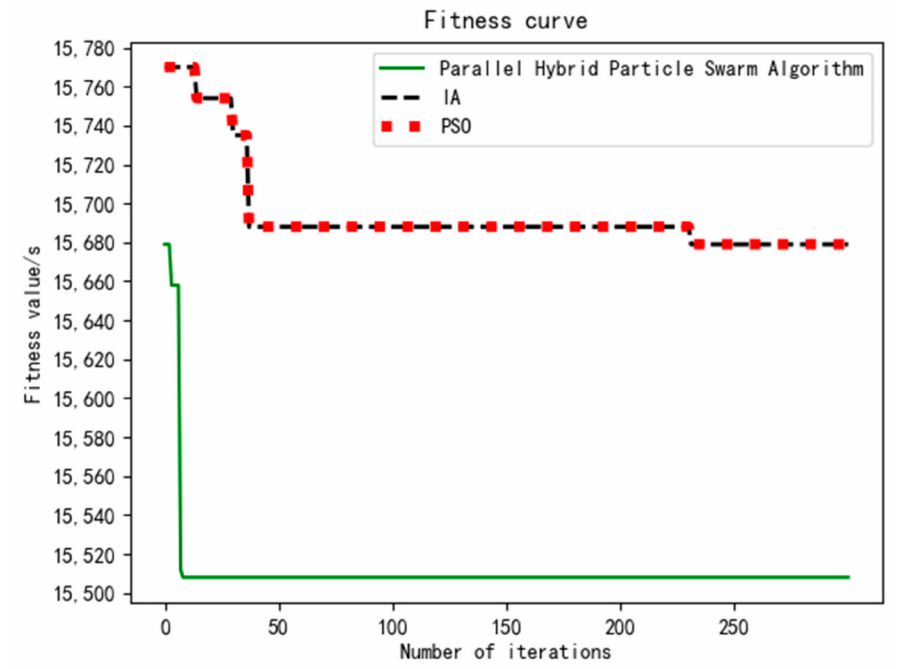
Figure 3. Algorithm evolution curve.